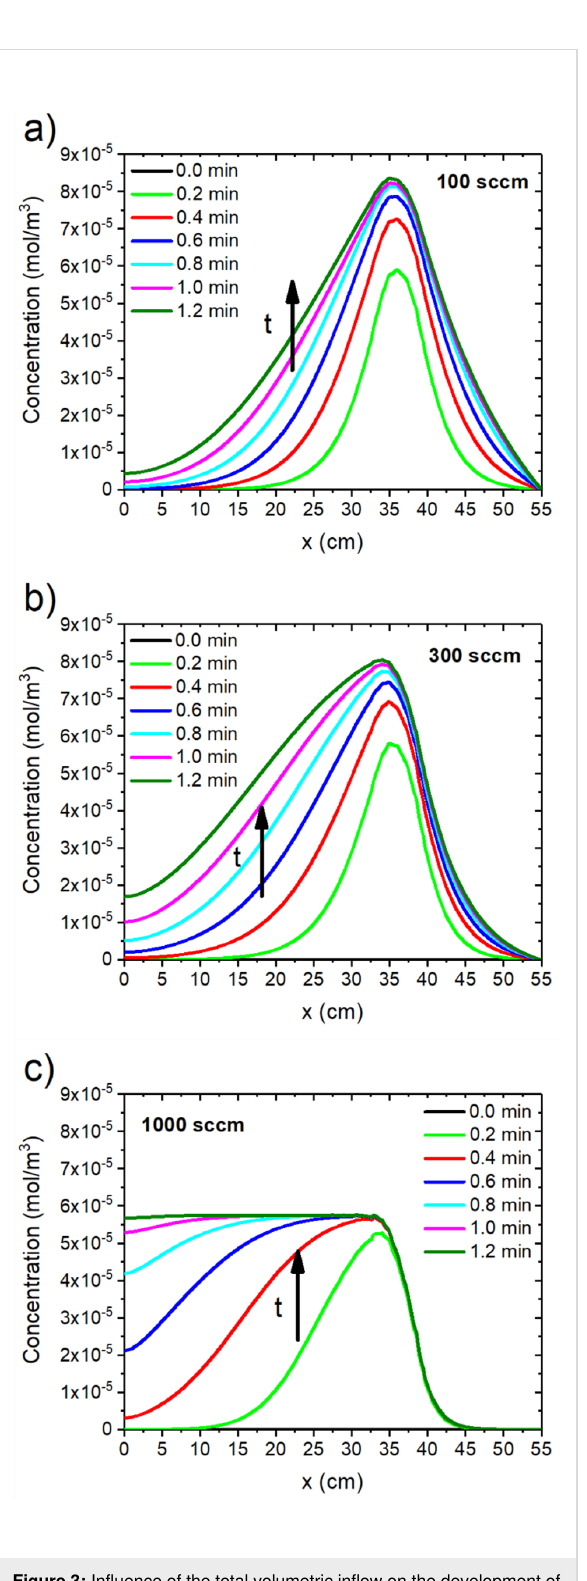
Figure 3: Influence of the total volumetric inflow on the development of the metal vapor concentration along the quartz tube: simulated time- resolved metal vapor concentration for a total volumetric inflow (from the right) of (a) 100 sccm, (b) 300 sccm and (c) 1000 sccm up to a time of 1.2 min. The simulated pressure is 1 bar.